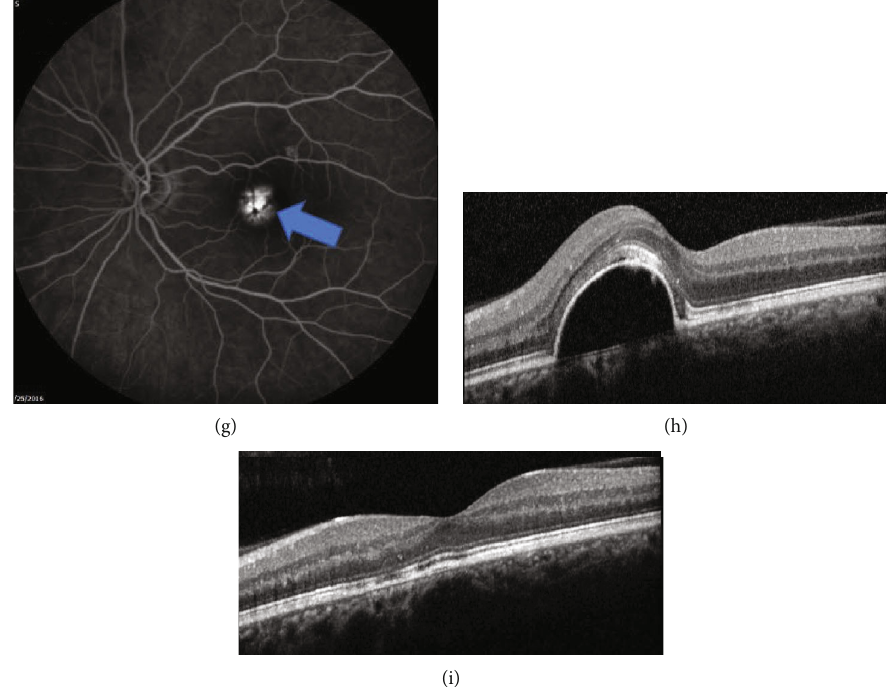
Figure 12: Chronic central serous chorioretinopathy of the left eye treated with both thermal laser photocoagulation and half fl uence photodynamic therapy (PDT). A 42-year old female presented with blurred vision for two years. (a – d) Images at baseline. (a) Fundus photography showed pigmentary changes around a pigment epithelial detachment (PED). (b) Early-phase fl uorescein angiography (FA) showed leakage in the fovea as well as slightly superotemporal. (c) Late-phase FA showed increased leakage; the superotemporal lesion is noted by the yellow arrow. (d) Optical coherence tomography (OCT) showed a large subfoveal PED. The patient was initially treated with thermal photocoagulation to the superotemporal lesion (yellow arrow in (c)), so as to spare the fovea. (e) Following thermal photocoagulation, the clinical appearance did not change. (f) Early-phase FA and (g) late-phase FA showed improvement of the treated superotemporal lesion but persistent leakage of the untreated subfoveal PED. (h) OCT showed no change in the subfoveal PED (noted by the blue arrow in (g)). The patient then underwent half- fl uence PDT (blue arrow in (g)). (i) One month later, OCT showed resolution of the pigment epithelial defect. Visual acuity improved from 20/30 to 20/20.